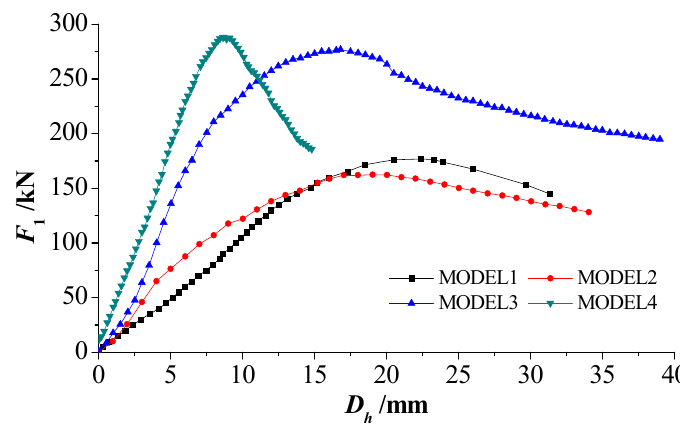
Figure 9. Top arch in model 4 after loading.